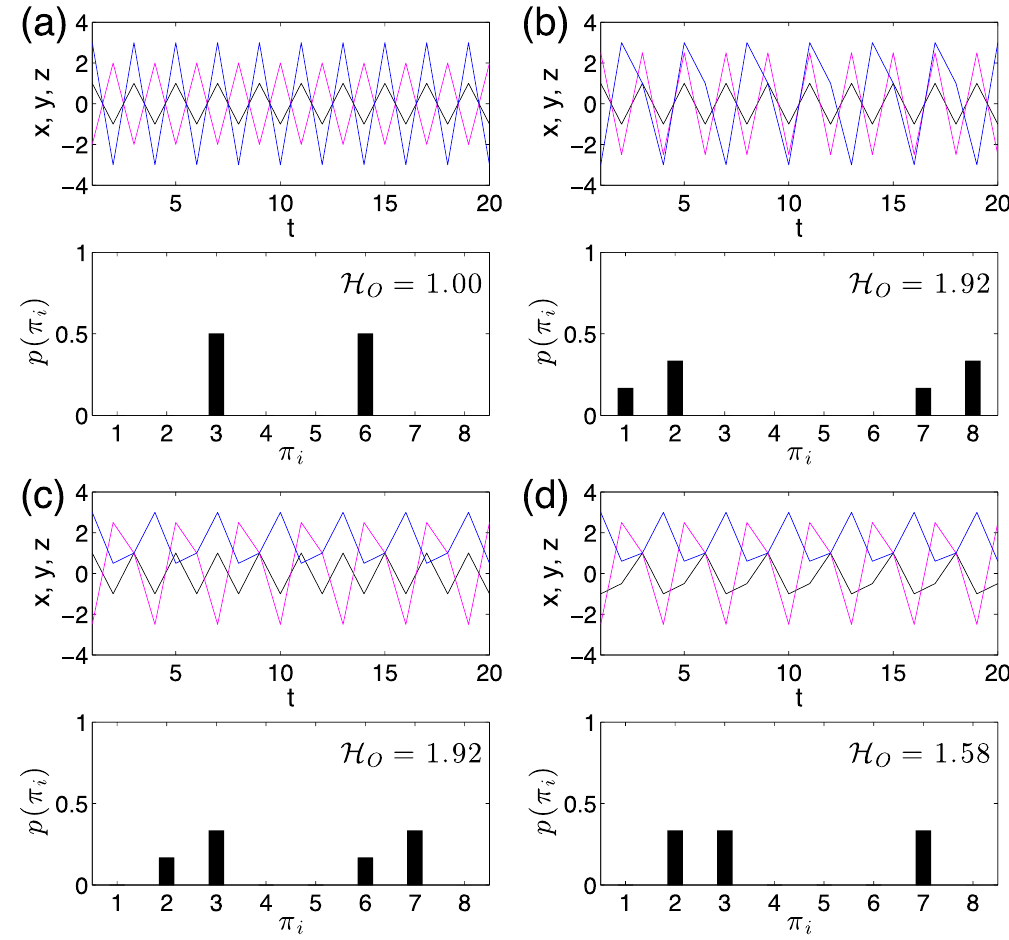
Figure 2. A toy model of periodic 3D series ( x ( t ), y ( t ), z ( t )) and its associated histogram of order patterns. ( a ) x ( t ), y ( t ), and z ( t ) has the same period 2. ( b ) x ( t ) and y ( t ) have period 2, but z ( t ) has period 3. ( c ) x ( t ) has period 2, y ( t ) and z ( t ) have period 3. ( d ) x ( t ), y ( t ) and z ( t ) have the same period 3. The respective frequency plot of the ordinal patterns is shown below the time series and entropy values 